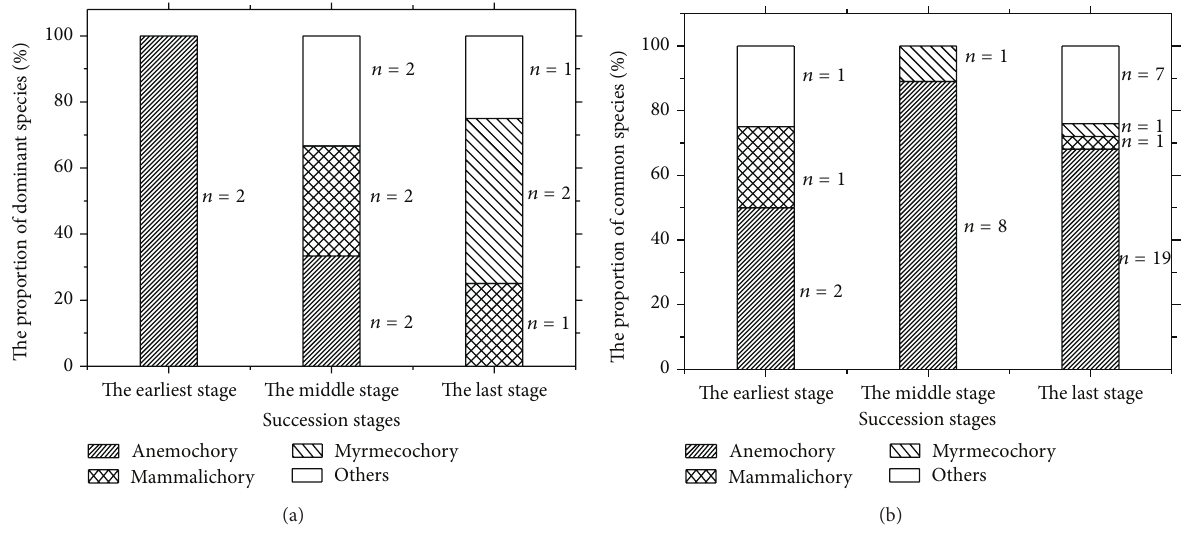
Figure 4: Dispersal modes of dominant species (a) and common species (b) from the earliest stage to the last stage of succession on the foreland of